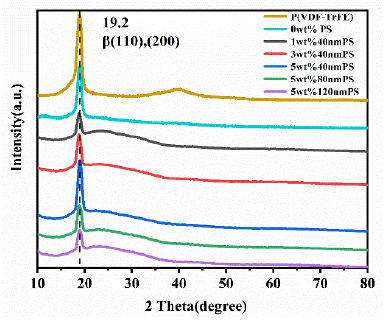
Figure 5. XRD patterns of blend films.